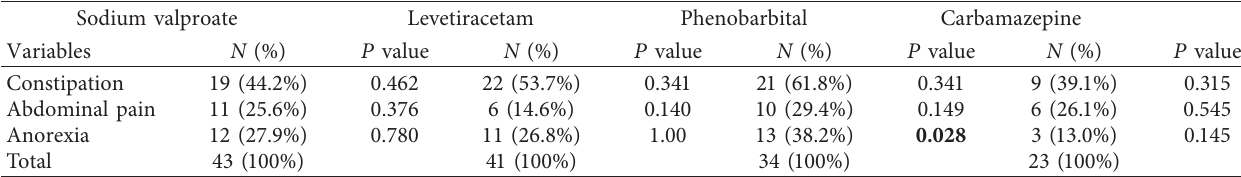
Table 2: The relationship between antiepileptic drugs and gastrointestinal symptoms in patients with intractable epilepsy. Sodium